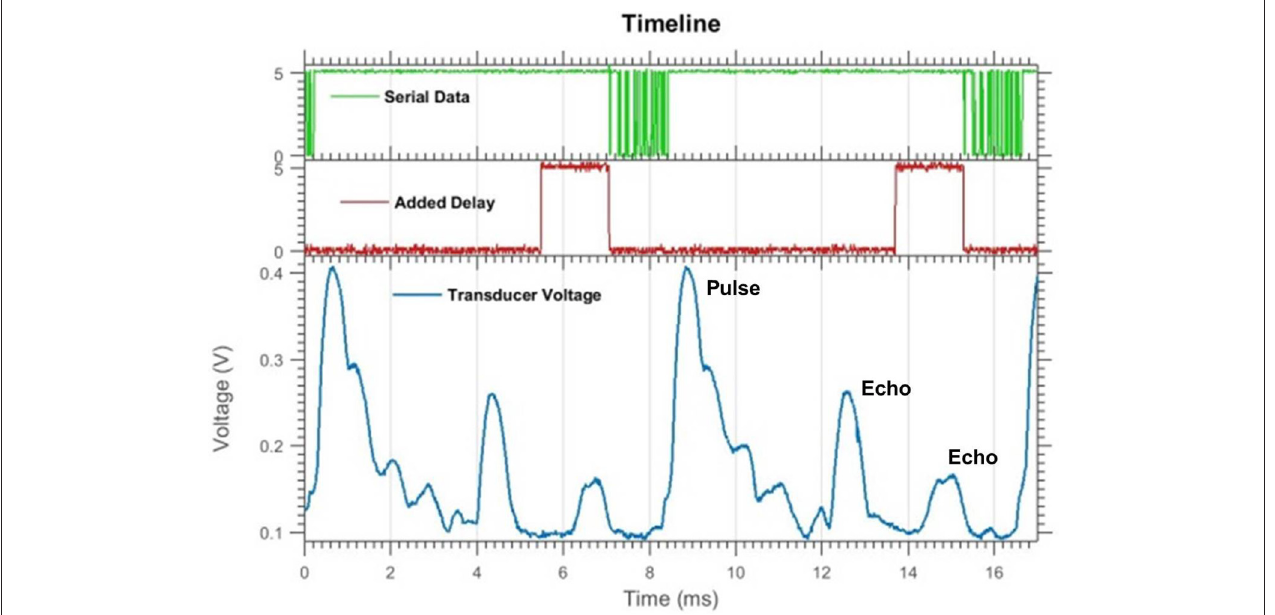
FIGURE 2 | An oscilloscope readout of two pulse-echo cycles (without aliasing) showing the transducer envelope voltage ( bottom ), serial data transfer ( top ), and added delay ( middle ). The added delay flag is set high when the delay is occurring. Objects can be seen as distinct peaks in the transducer voltage trace. Pulsing and sampling the transducer takes 5ms, then there is a 1.5ms delay and 1.5ms of serial data transfer. The whole cycle takes about